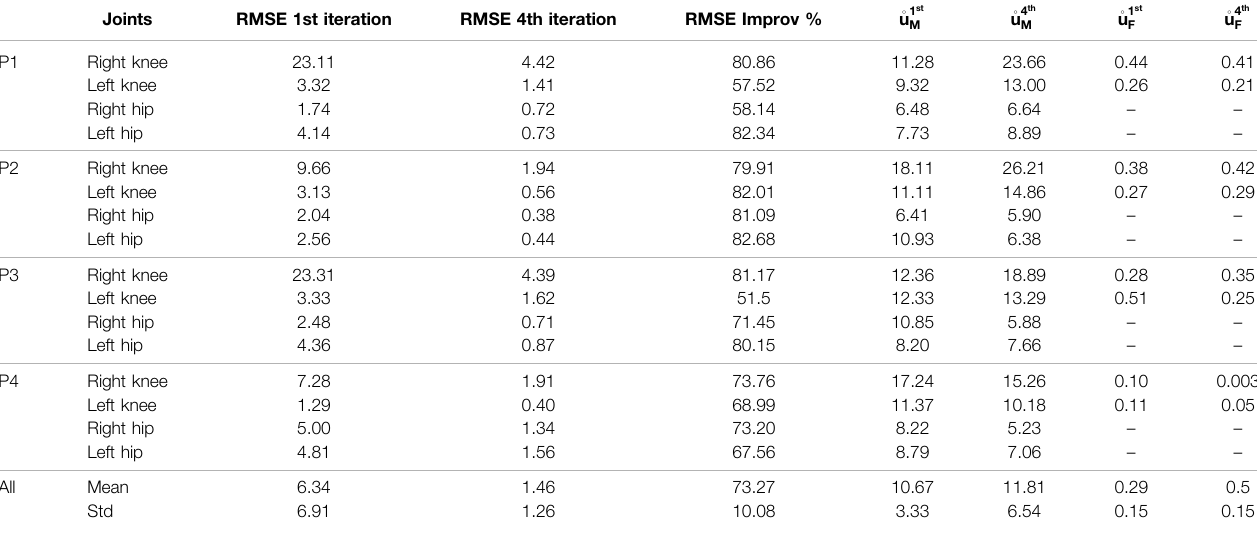
TABLE 4 | RMSE of trajectory tracking and inputs from motors and FES on each participant in the 1st and 4th iterations. Joints RMSE 1st iteration RMSE 4th iteration RMSE Improv